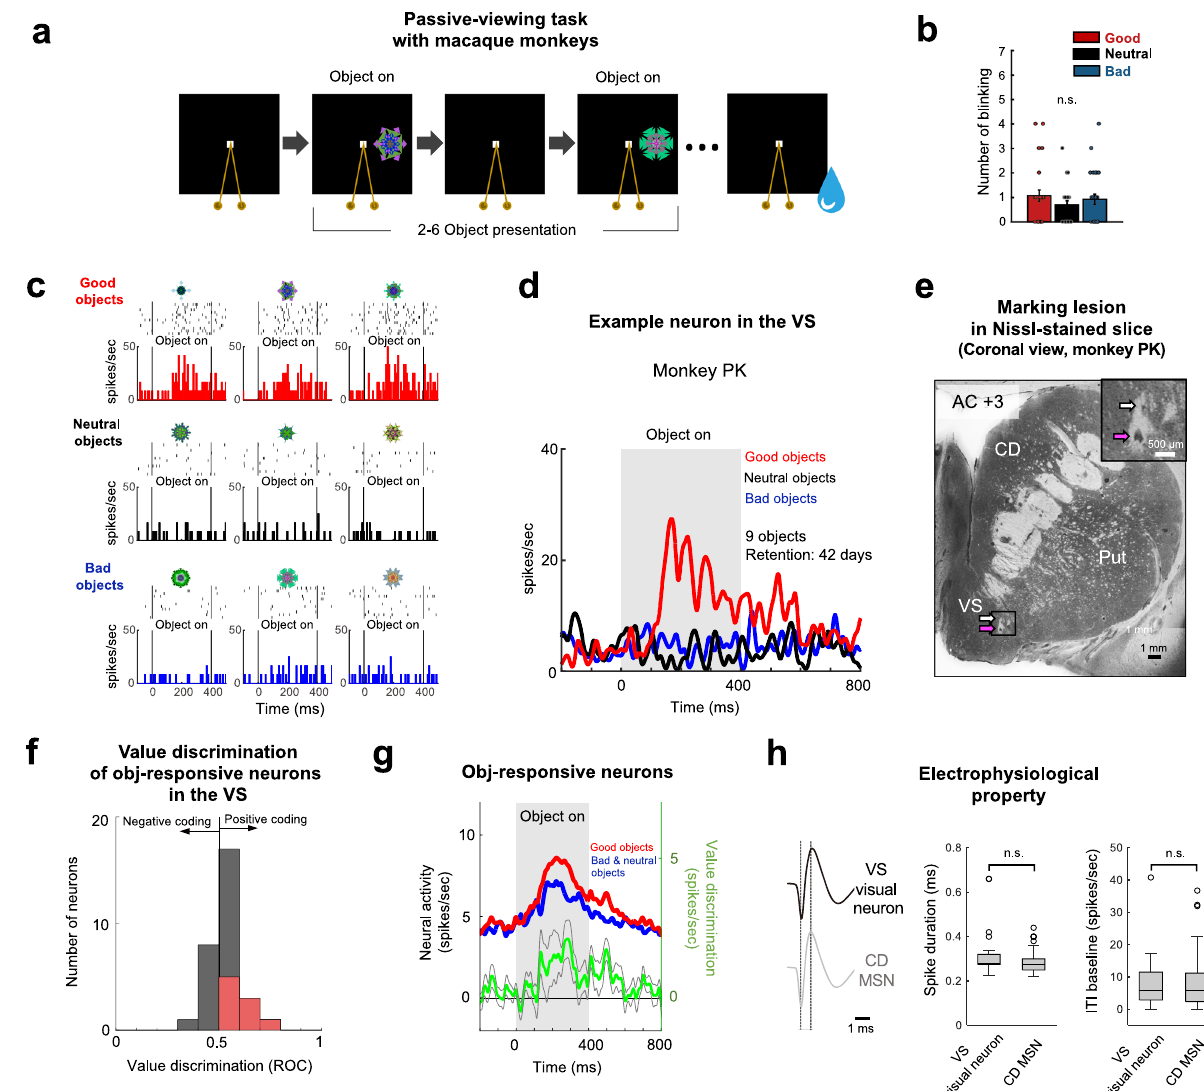
Fig. 4 Long-term value memory encoded in neurons of the monkey ventral striatum. a Passive-viewing task to examine the neural response to previously learned objects. While the monkey kept fi xating at a central white dot, two to six fractal objects were pseudorandomly chosen and sequentially presented. b Number of blinking per session of passive-viewing task consisted of 108 trials ( n = 27 sessions, one-way ANOVA with value as a factor, n.s. not signi fi cant). Error bars indicate s.e.m. Individual data points are plotted as dots. c An example neuron in the VS that encodes long-term value memory of visual objects. Shown are responses to nine long-term learned objects. d Average response of the example neuron to learned objects. Responses to good, neutral, and bad objects are shown in a peristimulus time histogram (PSTH). e Location of the example neuron that encodes the long-term value memory in the VS. The marking lesions were located in the VS. The magenta arrow indicates a marking lesion where the example neuron was recorded. Another marking lesion was made 1 mm above the neuron (white arrow). AC anterior commissure. f Value discrimination of visual VS neurons ( n = 30 cells). The difference in response to good and bad or good and neutral objects were calculated as the ROC area. Red bars indicate neurons that showed statistically signi fi cant value differences (two-tailed Wilcoxon rank-sum test, p < 0.05). g Population response of object-responsive neurons in the VS to learned objects in the passive-viewing task. The value discrimination activity is indicated by the green line (good-bad or good-neutral for monkey PK and monkey DN, respectively) (mean ± SEM). h Electrophysiological properties of putative medium spiny neurons (MSN) in the caudate nucleus (CD) and object- responsive neurons in the ventral striatum (VS). Object-responsive neurons in the VS ( n = 30 cells) and MSN ( n = 43 cells) in the CD had similar spike shapes (left panel), spike durations, and baseline activity levels (two-tailed Wilcoxon rank-sum test, n.s. not signi fi cant) (middle and right panels). The middle line indicates the median, and the bottom and the top of the box correspond to the 25th and 75th percentiles, respectively. The upper and lower whiskers extend to the highest and lowest values that are within 1.5 times interquartile range of the hinge. Outlying data beyond this are plotted as